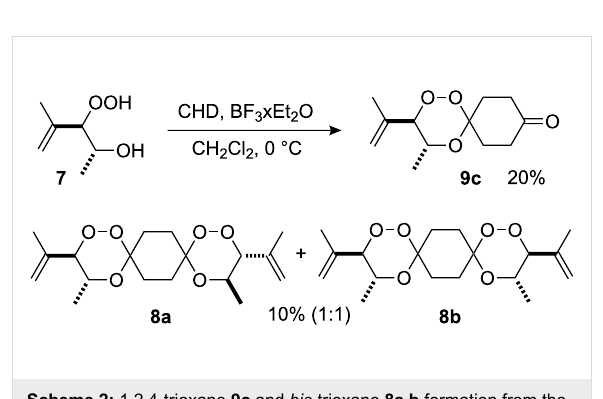
bifunctional cyclohexane-1,4-dione (CHD, Scheme 2). In